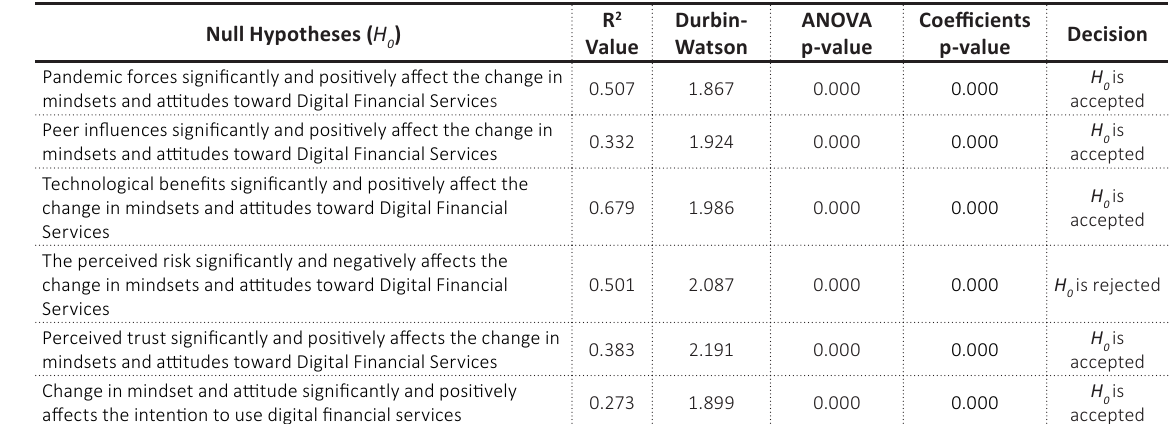
Table 8. Linear regression